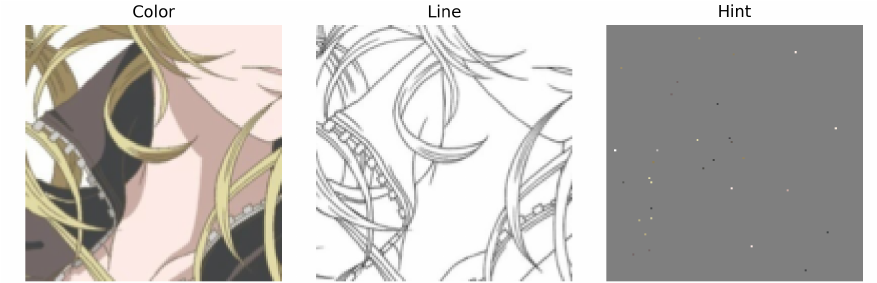
Figure 5. Three pairs of images for pre-processing (Gray has alpha value of 0 in the hint